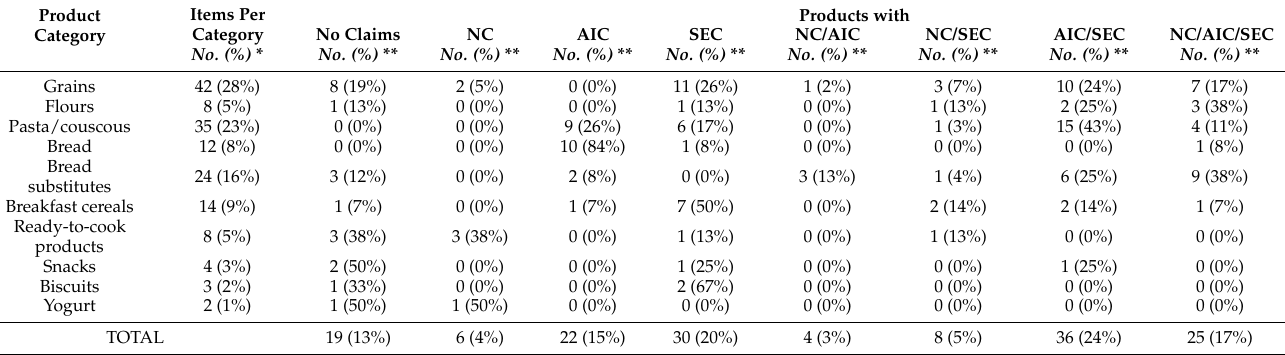
Table 1. Distribution of claims across the main product